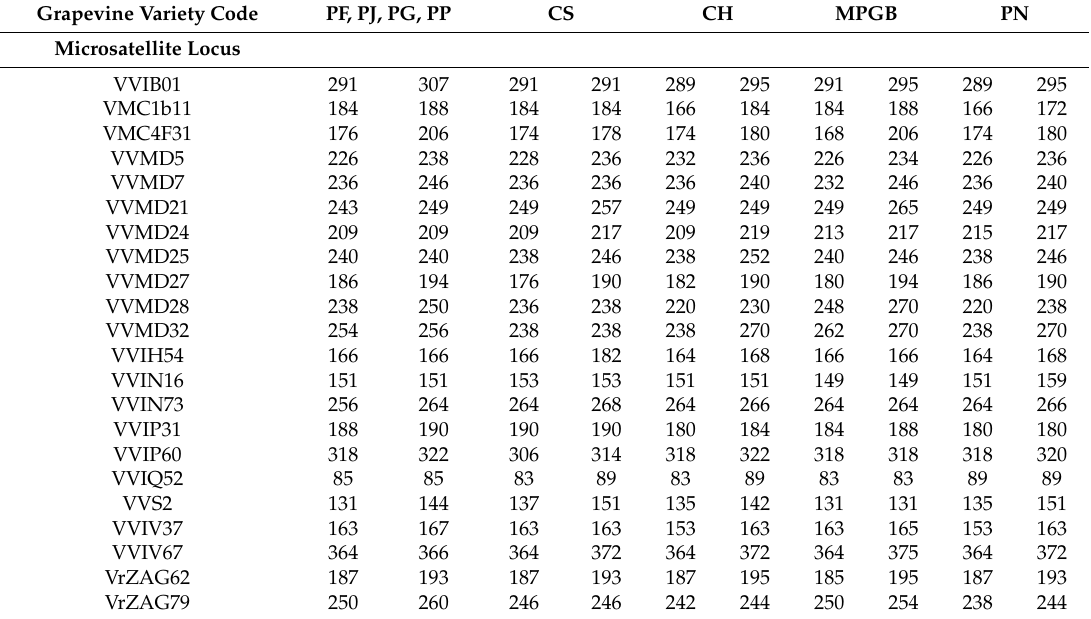
Table 1. Genetic profiles of di ff erent Palomino variants at 22 microsatellite loci. Allele sizes are given in base